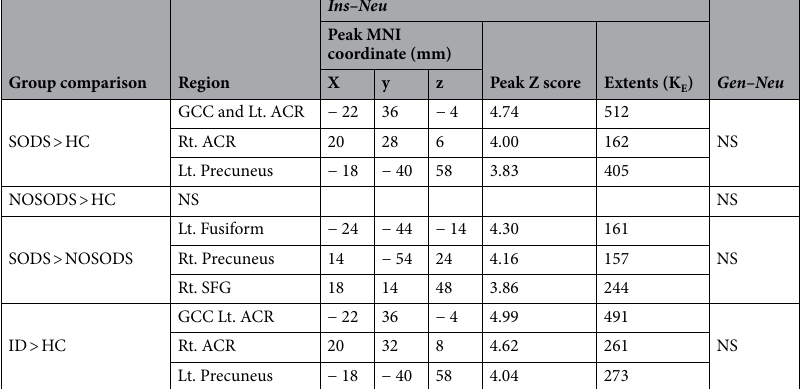
Table 1. Group comparison results exhibiting significantly increased BOLD signals in the Ins vs. Neu and Gen vs. Neu contrasts. The statistical threshold was voxel-wise uncorrected p < 0.001 with cluster-wise FWE corrected p < 0.05 (141 voxels). FWE corrected cluster size was calculated using 3dClusSim. x, y, z are coordinates of maximum activated brain region in MNI (Montreal Neurologic Institute) stereotactic standard brain template. SODS insomnia with subjective–objective discrepancy of sleep, NOSODS insomnia without subjective–objective discrepancy of sleep, HC healthy control, NS no significant finding, ID insomnia disorder (SODS + NOSODS), Ins insomnia item, Neu neutral item, Gen general item, GCC genu of corpus callosum, ACR anterior corona radiate, SFG superior frontal gyrus, FEW family wise error.